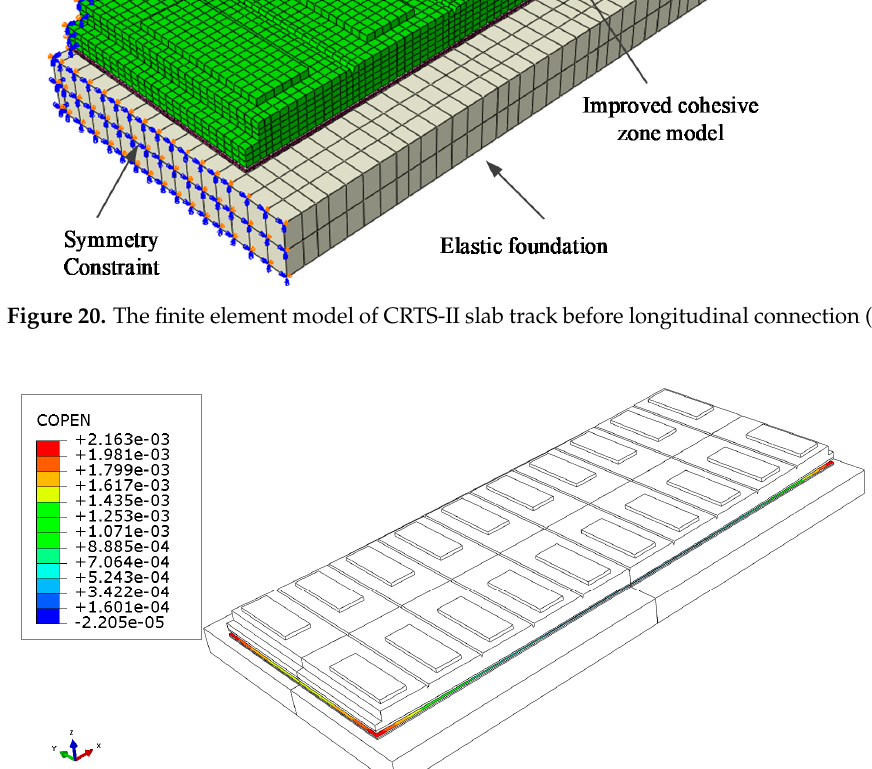
Figure 21. Interface crack opening (COPEN) distribution of the slab track system as a result of temperature change (scale factor is 20).